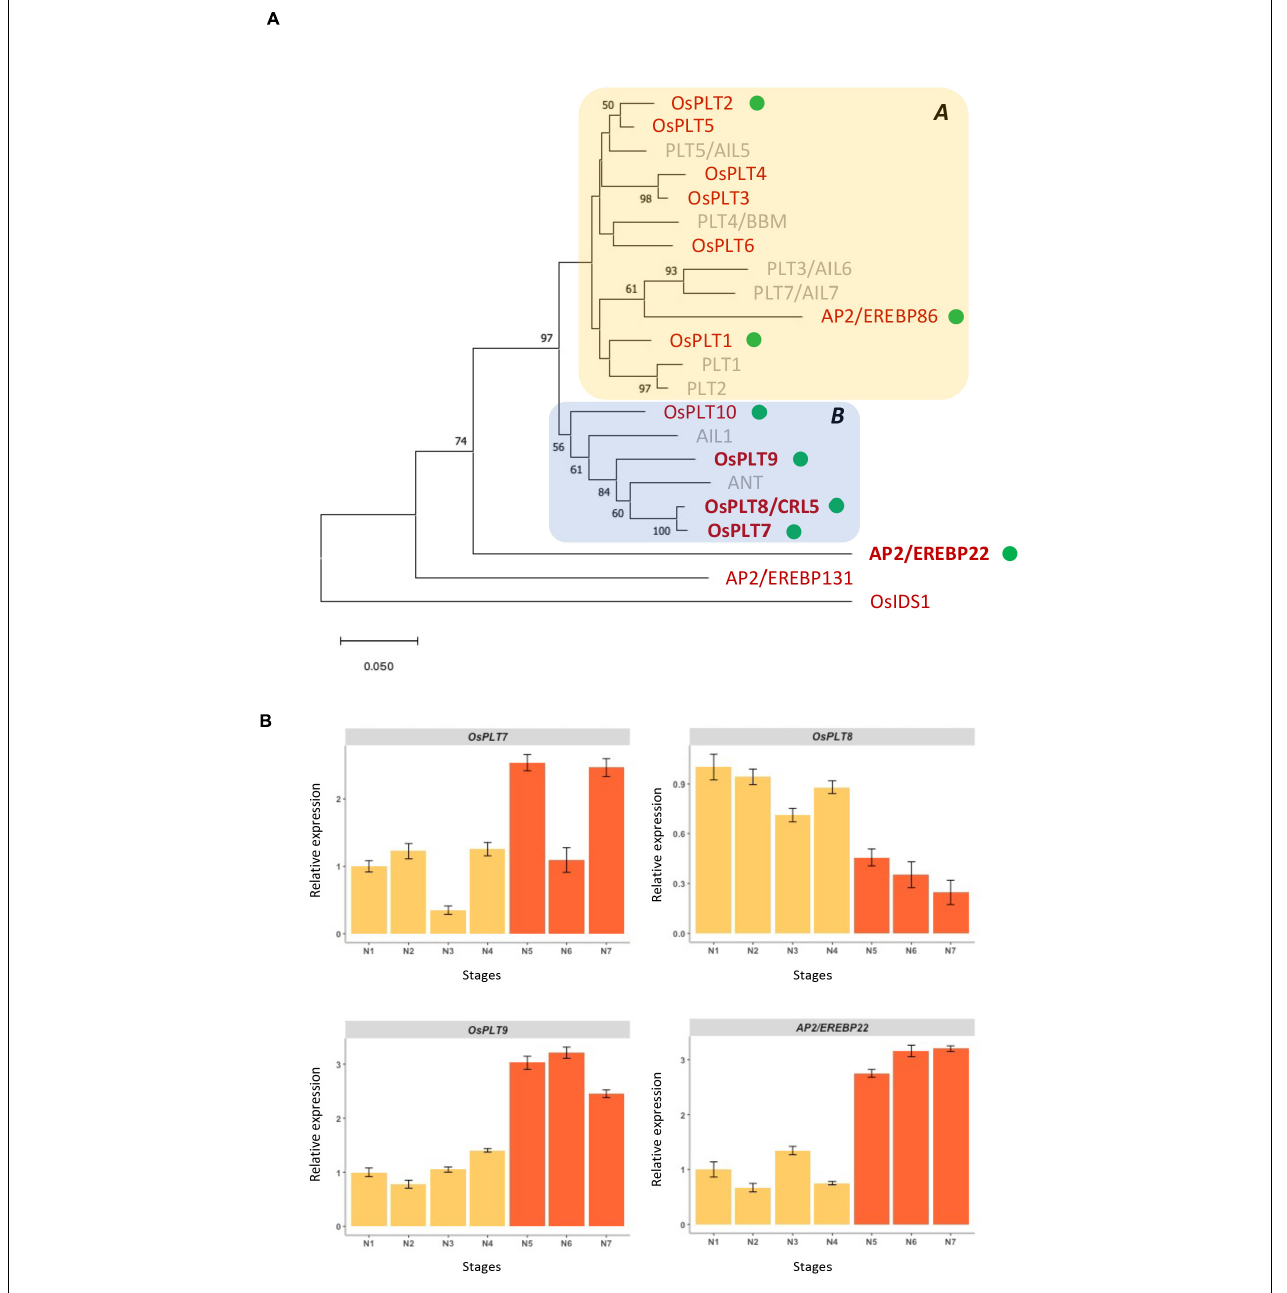
FIGURE 1 | Phylogenetic relationships of O. sativa and A. thaliana euANT/PLT genes and expression patterns of O. sativa ANT homologs during panicle development. (A) Phylogenetic tree of the deduced amino acid sequences comprising the two AP2 domains and the linker of the euANT/PLT proteins from O. sativa cv. Nipponbare (red) and A. thaliana (gray) using the NJ method. Bootstrap values (1,000 tests), when equal to or greater than 50%, are indicated at individual nodes. Members of clades A and B, as defined by Li and Xue (2011), are indicated by colored boxes. O. sativa genes for which transcripts were detected in the young panicle via RNAseq (Harrop et al., 2016, 2019) are indicated by green dots. O. sativa genes selected for further analysis during the panicle development are indicated in boldface. AP2-EREBP131 and OsIDS1 were used as outgroups, as members of the basalANT and euAP2 groups, respectively. (B) Expression analysis of the O. sativa ANT homologs and AP2/EREBP22 gene during the panicle development using qRT-PCR. N1, rachis meristem; N2, primary branch initiation; N3, early primary branch elongation; N4, primary branch elongation with axillary meristems; N5, spikelet meristem differentiation; N6, floret meristem differentiation; N7, floral organ establishment. Stages N1 to N4 correspond to indeterminate stages (yellow bars), while stages N5–N7 to determinate stages (orange bars). Data are given as means ± SD from three independent biological replicates.